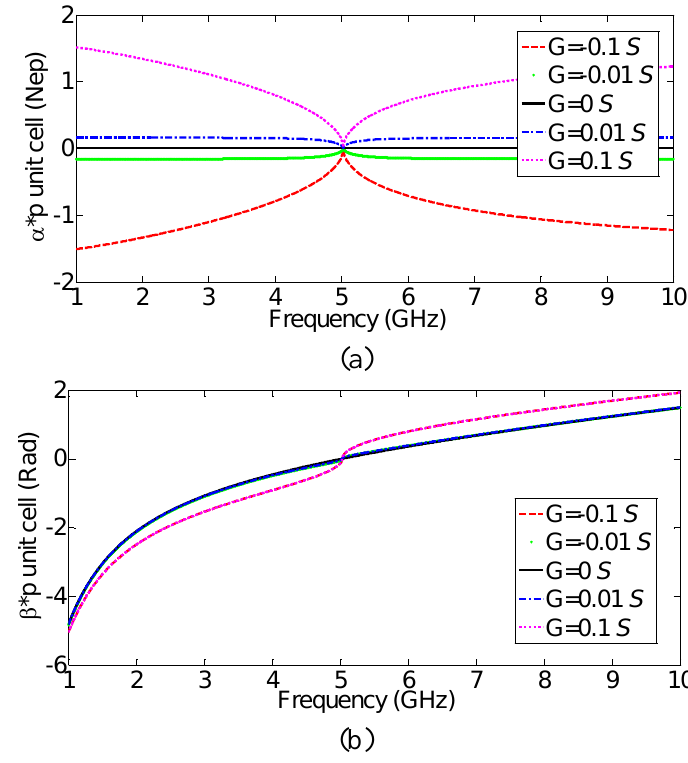
Figure 5. ( a ) Attenuation constant  and ( b ) phase constant  , of several CRLH-TLs with different shunt conductance